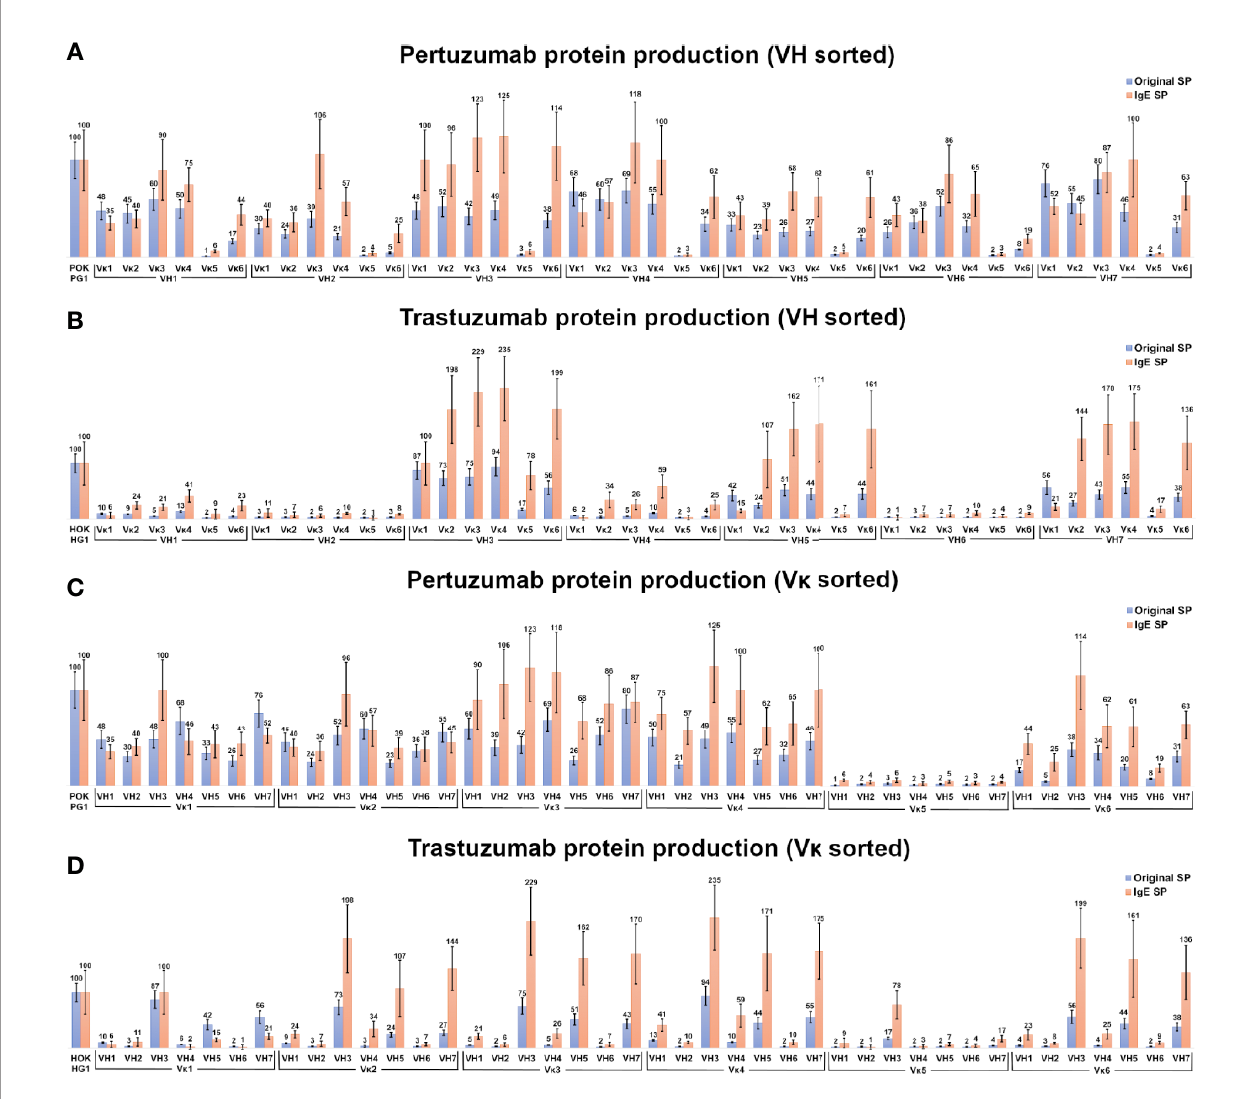
FIGURE 2 | Production rates (%) of recombinant antibodies containing various heavy and light chain pairings. (A, B) Recombinant Pertuzumab (A) and Trastuzumab (B) variants with the various SPs grouped according to VH families. (C, D) Recombinant Pertuzumab and Trastuzumab variants with the various SPs grouped according to V k families. Recombinant Pertuzumab and Trastuzumab variants produced with native (blue) or the ’ IgE ’ (orange) SPs respectively, are shown. In all experiments, the recombinant wild-type Pertuzumab (POK PG1) or Trastuzumab (HOK HG1) was used (shown in the fi rst column) for normalization. The production rate of the variants utilizing the ‘ IgE ’ SP (23) was used as the reference for the production